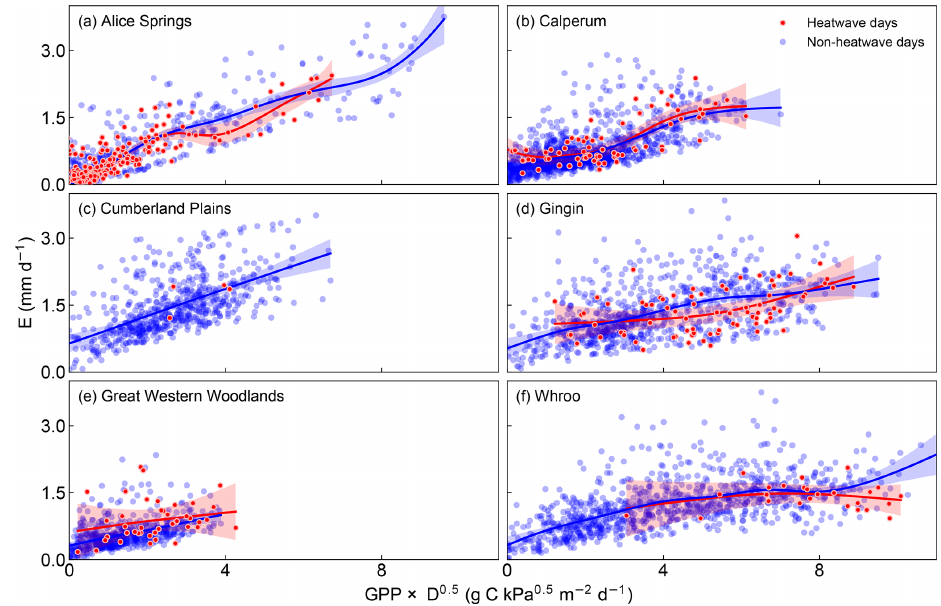
Figure 5. E as a function of GPP × D 0 . 5 on heatwave and non-heatwave days. The solid lines are smoothed time series using a generalized additive model (with a 95% confidence intervals). Note that data from Wombat State Forest have also been omitted from the graph as there were insufficient heat wave events and the generalized additive model was not fit to the heatwave days at Cumberland Plains due to the limited